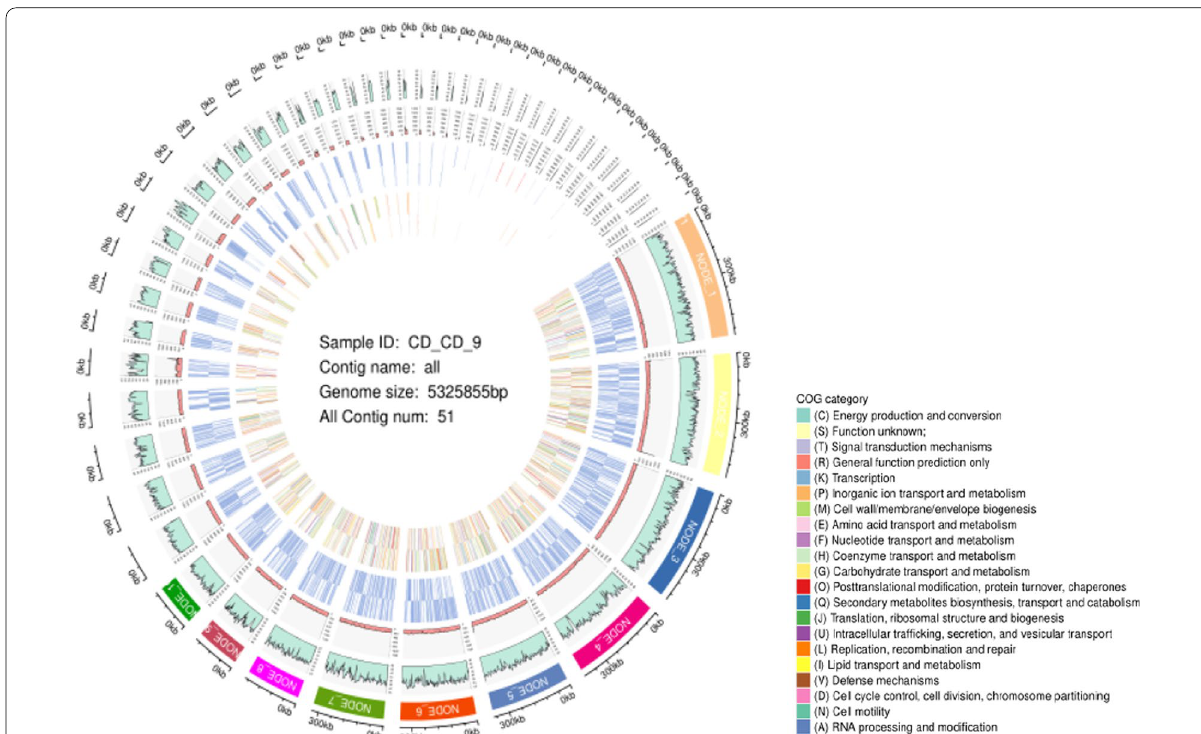
Fig. 2 Draft genome C. freundii CGMCC 20106. The first circle is contigs and corresponding length information, the second circle is GC content information, the third circle is the corresponding base sequencing depth, the fourth circle and the fifth circle are CDS, rRNA, tRNA distribution information, and the sixth circle and the seventh circle are the corresponding COG function classification. (From outmost to innermost)